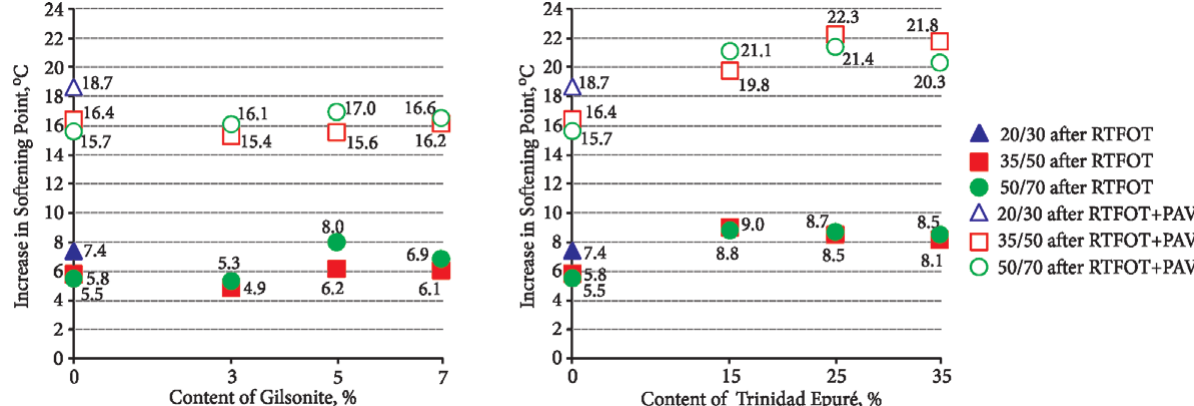
Fig. 2. The softening point rise of the Gilsonite and Trinidad Epuré modified asphalt binders as a result of aging using the RTFOT method and aging using both the RTFOT and the PAV